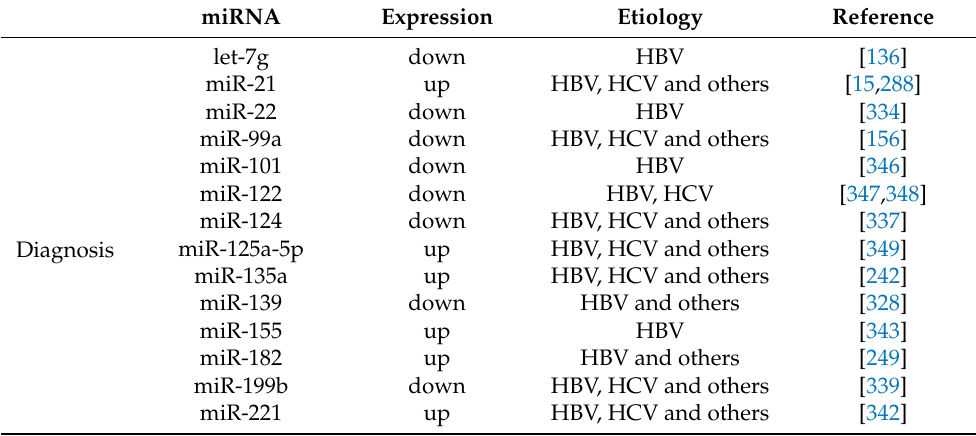
Table 2. miRNAs as biomarkers for